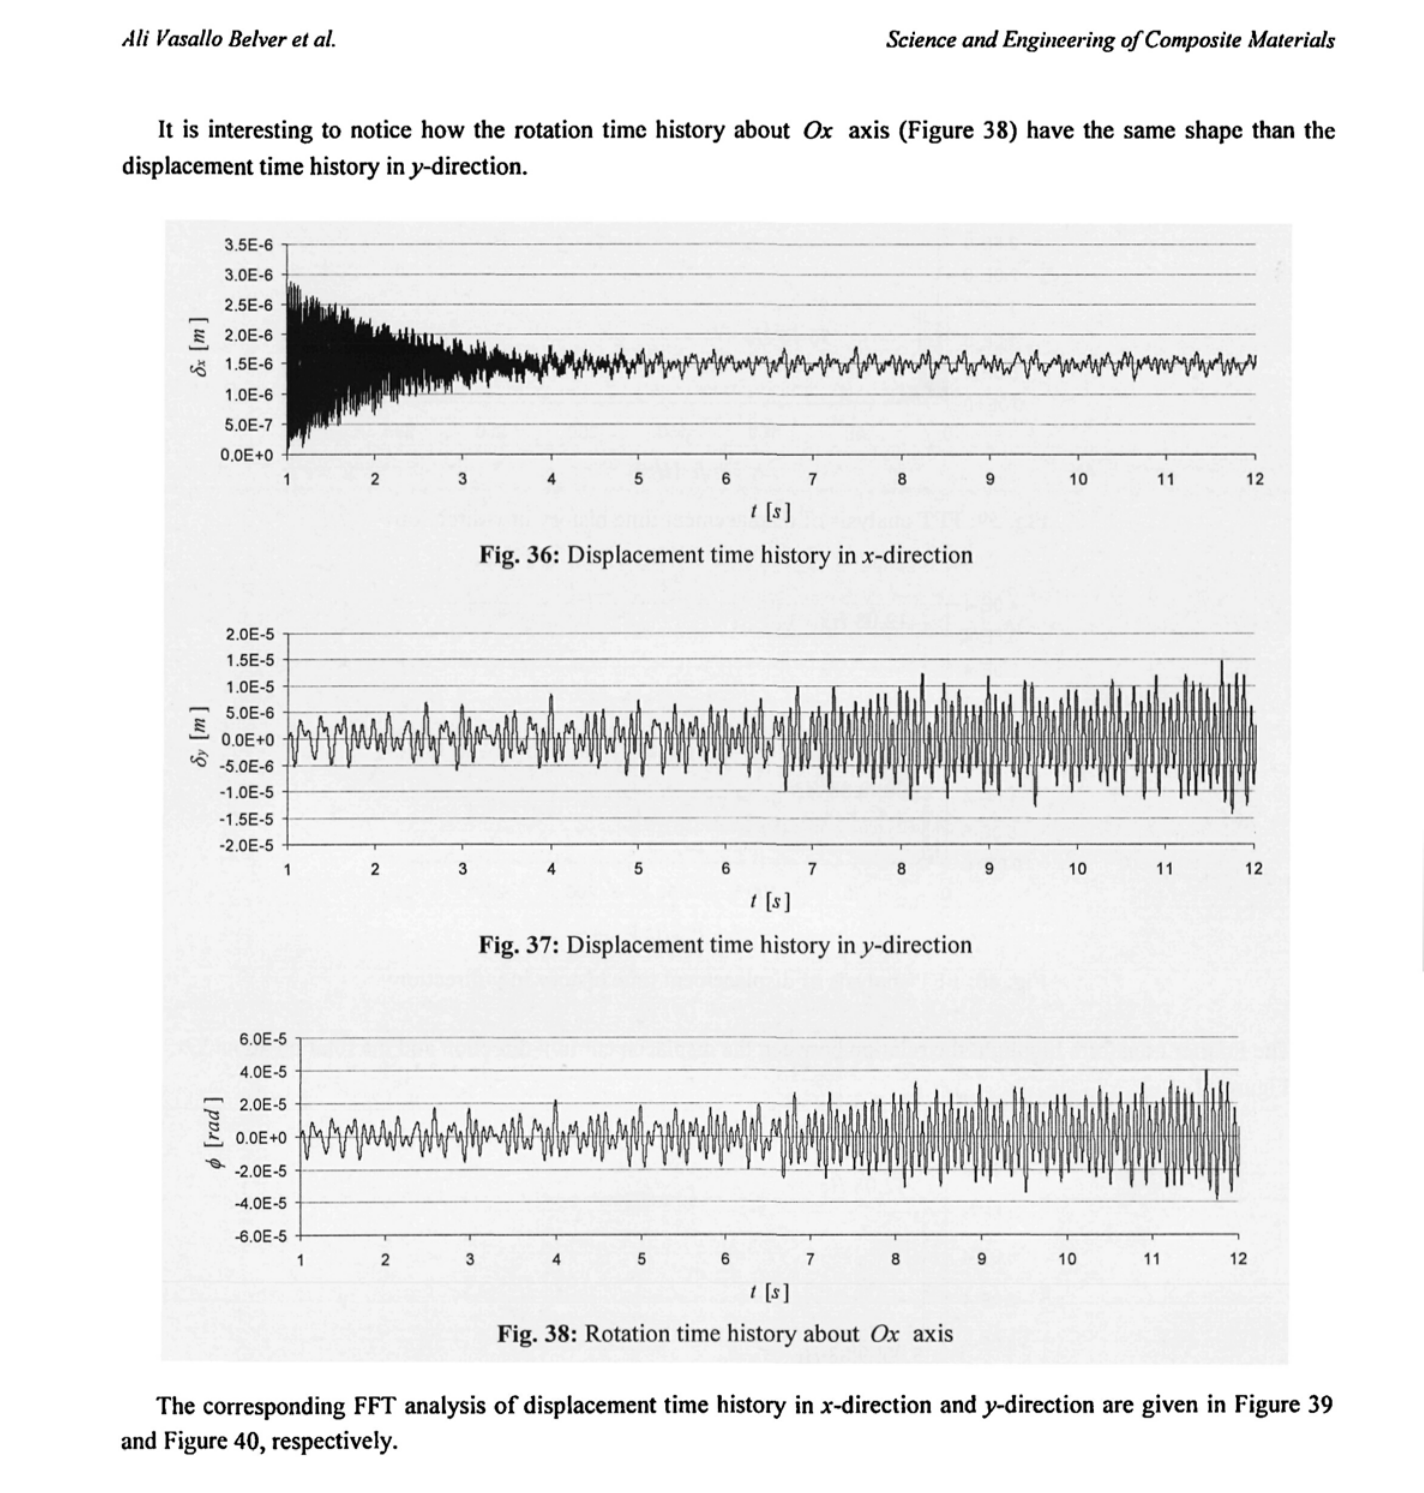
Fig. 36: Displacement time history in ^-direction